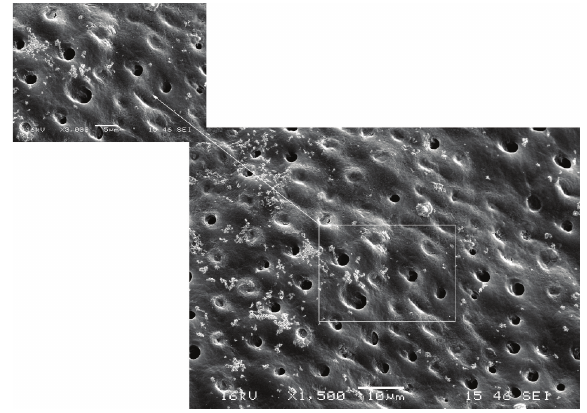
Figure 3: SEM ( × 1500, × 3000) showing dentin surface in sonic technique